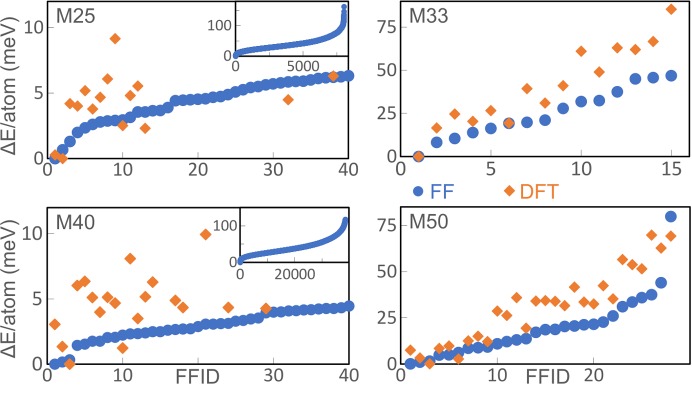
Relative total energies of geometrically optimized supercells with respect to the most stable supercell. The horizontal axis (FFID) is the permutation number which is identical to the rank determined by FF calculations (blue circles). The relative total energies per atom determined by DFT calculations (orange diamonds) are expressed relative to the total energy of the supercell which according to the DFT calculations is most stable (#1).